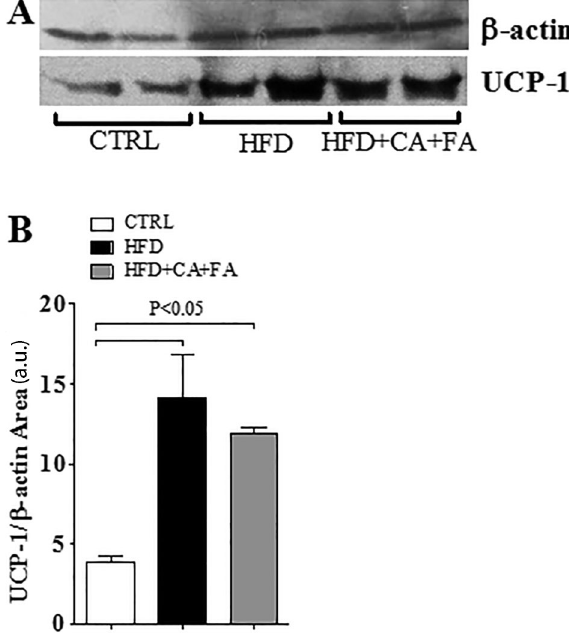
Figure 5. Effect of a high-fat diet (HFD) with combined treatment of caffeic acid (CA) and ferulic acid (FA) (0.9 and 50 mg (cid:3) kg – 1 (cid:3) day – 1 , respectively) on brown adipose tissue. A, UCP-1 by Western blotting of all groups; B, UCP-1 expression performed by Western blotting of all groups. Data are reported as means ± SEM of fi ve animals per group ANOVA followed by the Student Newman-Keuls test were used for statistical